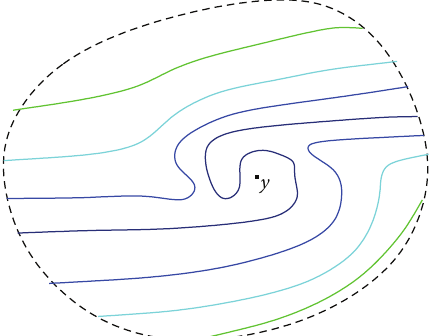
Figure 10: A function that is Lebesgue monotone, but is not Cone monotone.